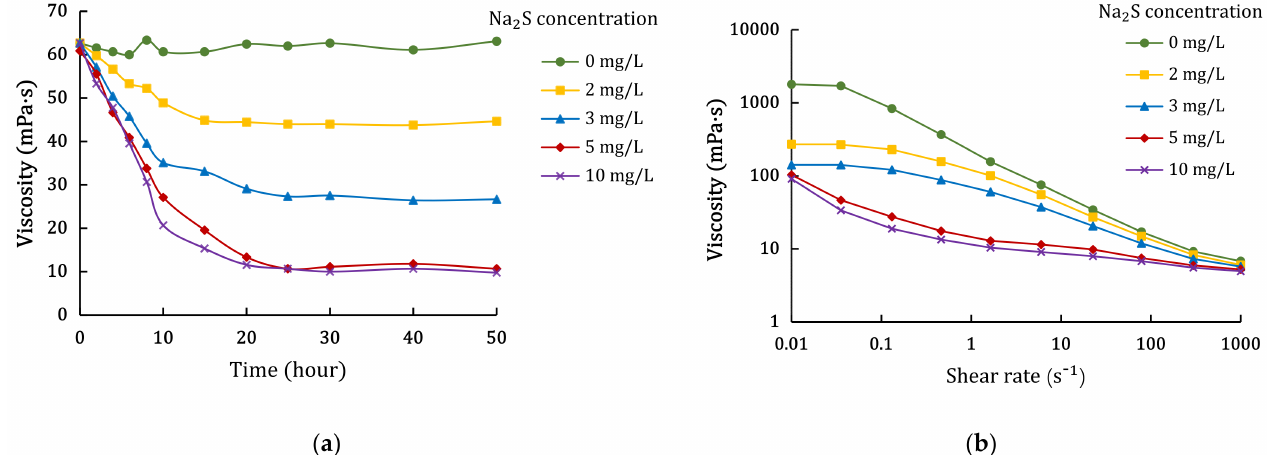
Figure 3. Effect of sulfide ion concentrations on the apparent viscosity of the polymer with the time ( a ) and shear rate ( b